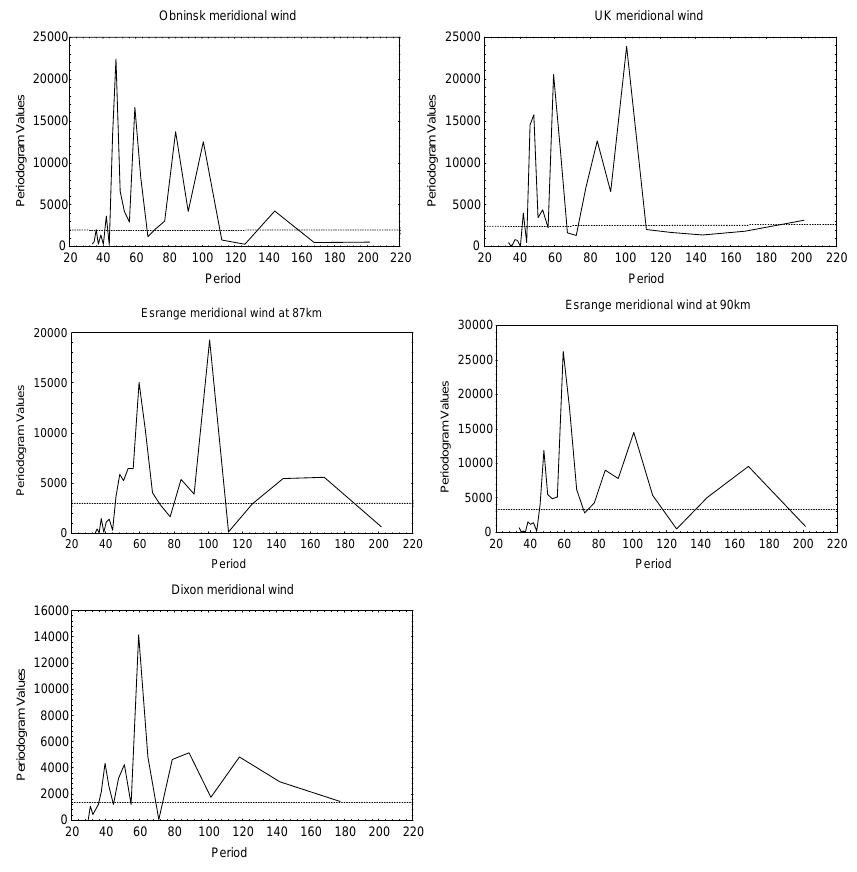
Fig. 8. (b) As for (a), but for meridional wind oscillations.